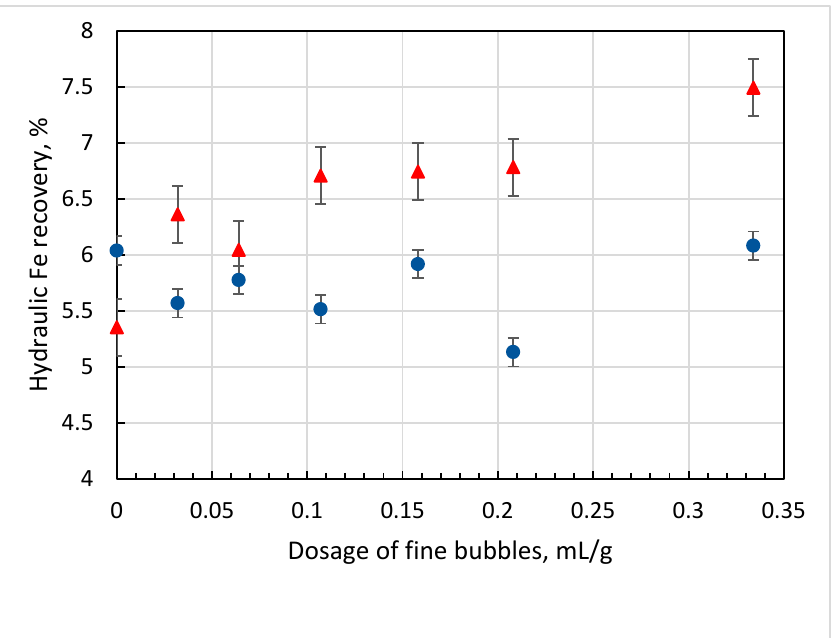
Figure 6. Dependence of the share of hydraulic entrainment of iron in tailings (froth product) on the fine bubble dosage at CTAB consumptions of 20 and 24 g/t. Treatment time in a TFR is 7.5 s. TFR inner diameter is 6 mm. Coefficient of the hydraulic entrainment of iron k Entr = 0.9, coefficient of pulp dilution in column k s = 0.38.